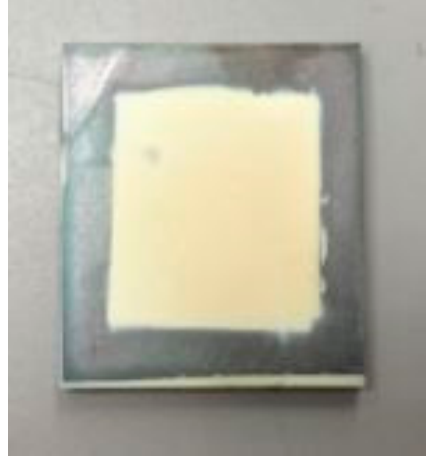
Figure 1. Optical image of 50-µm-thick and 400 mm 2 Mn-doped CBT/PZT films fabricated on 3-mm-thick and 900 mm 2 titanium substrate.